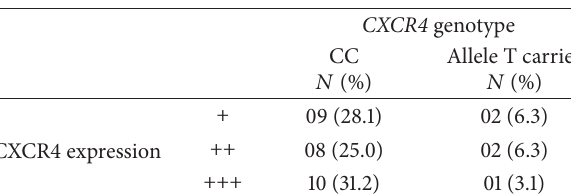
Table 3: CXCR4 protein expression according to rs2228014 geno-